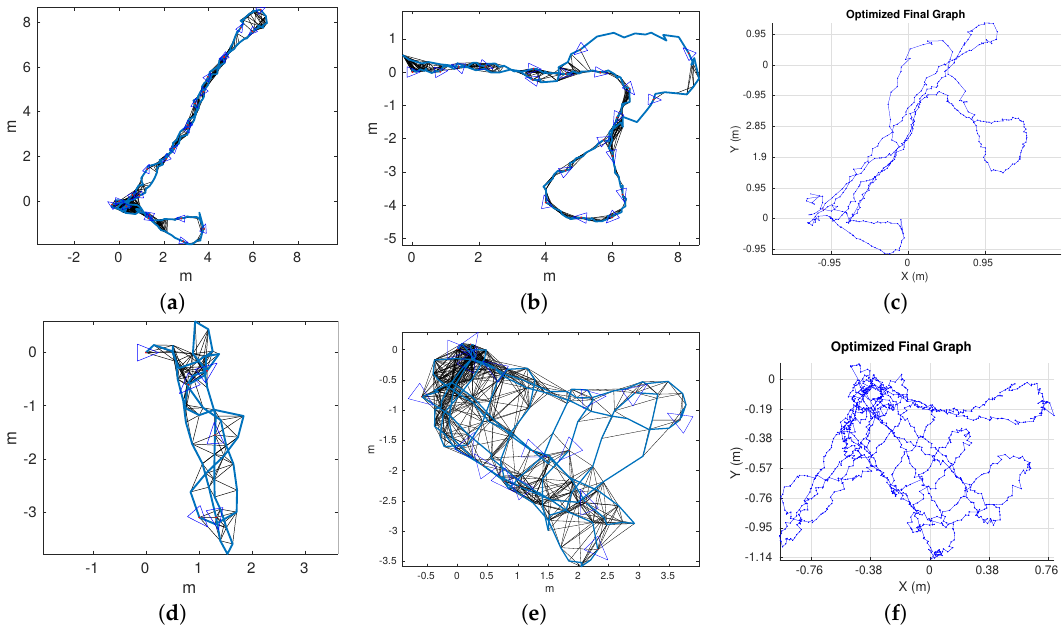
Figure 6. ( a ) Trajectory S 11, ( b ) Trajectory S 12, ( c ) Multi-robot final graph from S 11 and S 12.